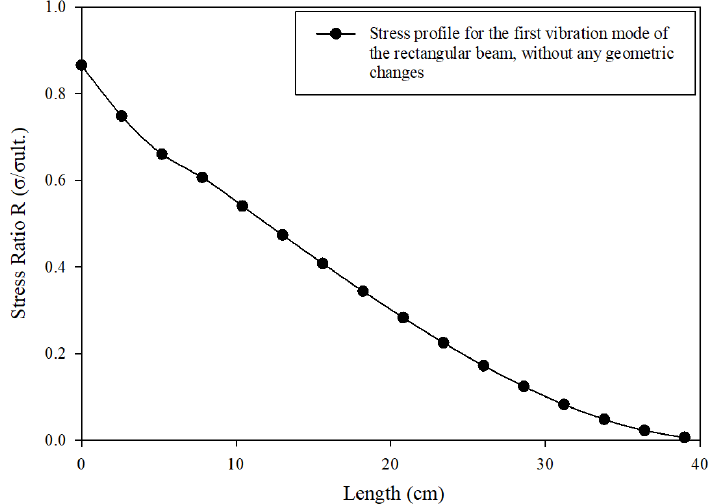
Figure 7. S tress profile in first mode without geometric changes. Figure 7. Stress profile in first mode without geometric